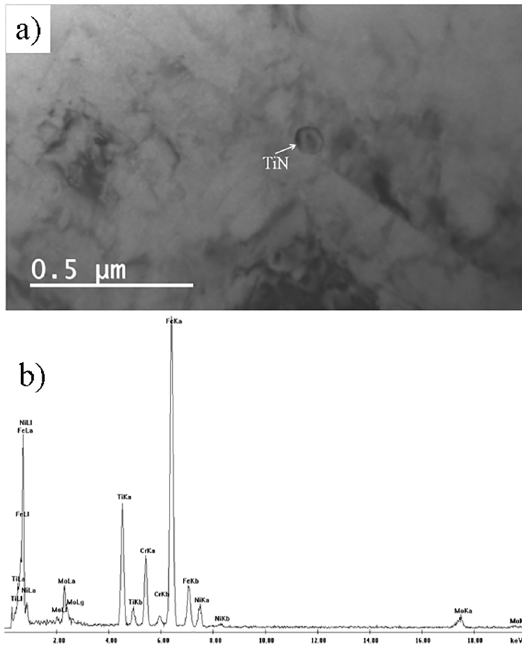
Figure 3. (a) Transmission electron micrograph of TiN on the SMSS surface and (b) EDS spectrum of TiN precipitate indicated in (a).